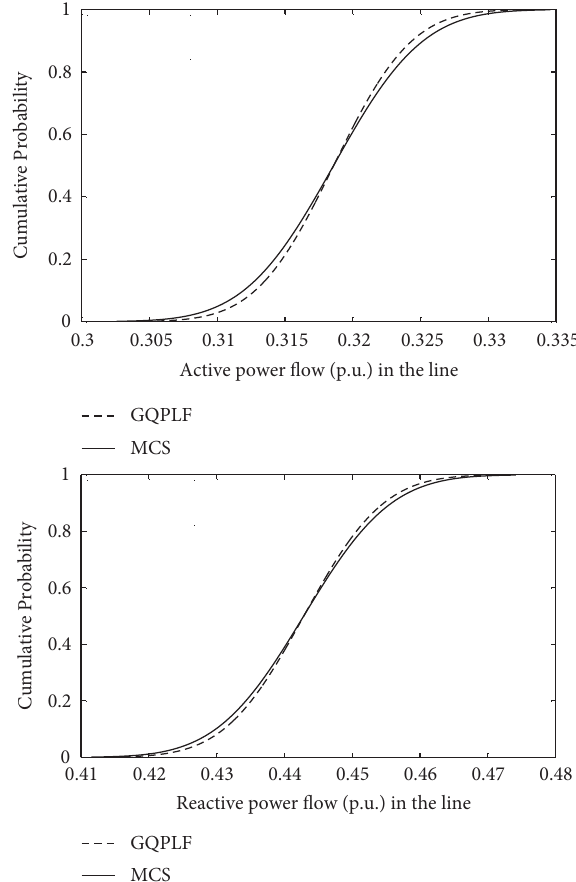
Figure 5: Distribution function of power fows in line connected between bus no.